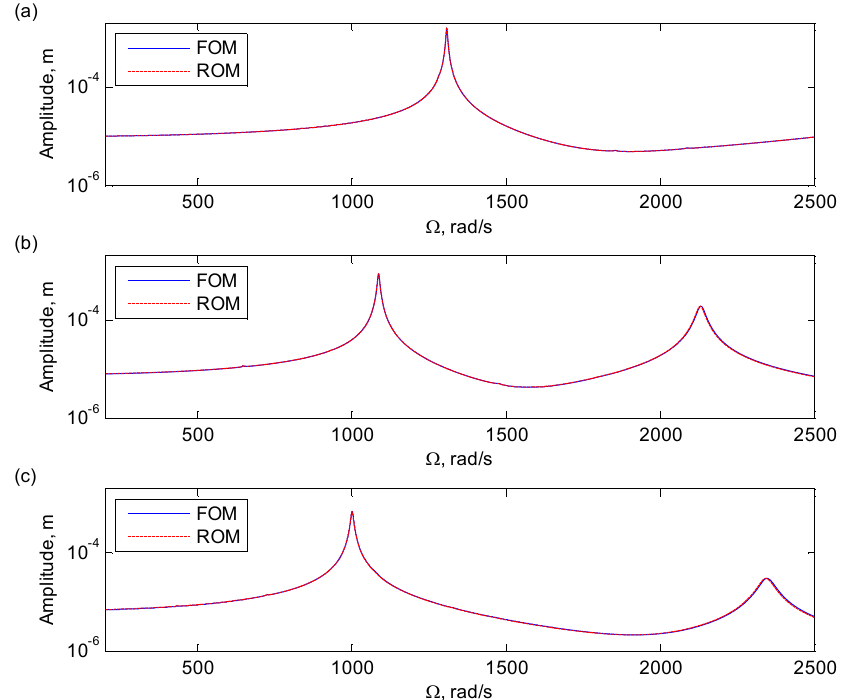
Figure 7. Comparisons of the forced responses of the excitation nodes of the assembly with disc mistuning between the full-order model and reduced-order model with excitations of ( a ) 1EO, ( b ) 2EO, and ( c ) 3EO. The full- and reduced-order models contain 103,563 and 7179 DOFs, respectively.